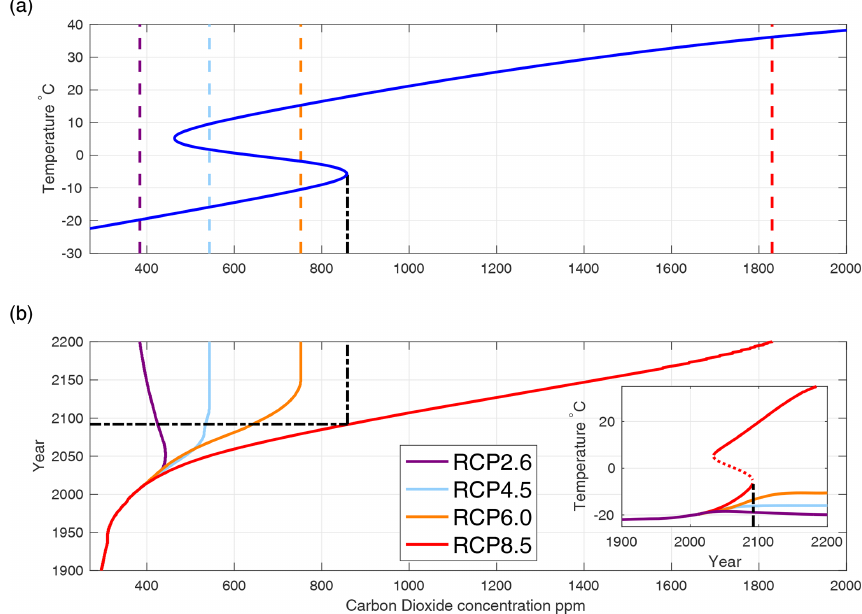
Figure 4. (a) Model surface temperature as a function of CO 2 concentration, µ . (b) CO 2 concentration levels for RCPs 2.6, 4.5, 6.0, and 8.5 (left to right). The dashed lines in panel (a) correspond to the CO 2 concentration levels for the four RCPs in the year 2200. The dashed-dotted line extends from the bifurcation point in panel (a) to RCP8.5 in the lower panel, indicating the bifurcation occurs in approximately the year 2100 for this scenario. The inset shows the predicted surface temperature as a function of the year for the four RCPs.